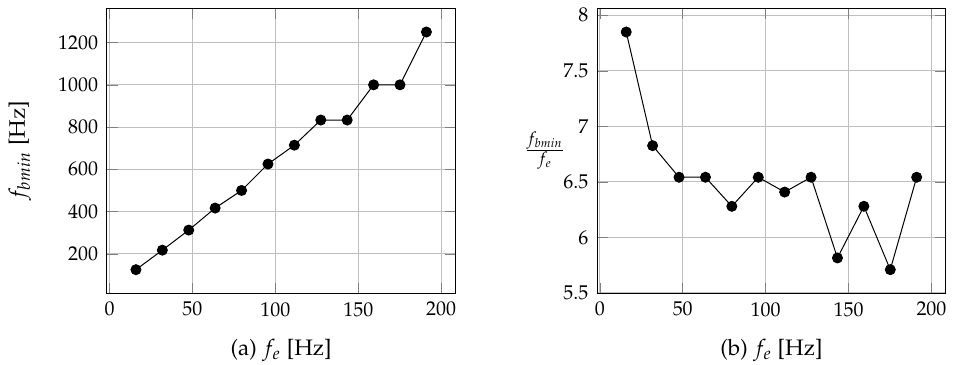
Figure 12. Experimentally measured relation between the minimum required Kalman matrices calculation frequency f bmin and the rotor electrical frequency f e . ( a ) the relation between mini- mum required f bmin and f e , ( b ) the relation between the ratio of f bmin to f e and the rotor electrical frequency f e .